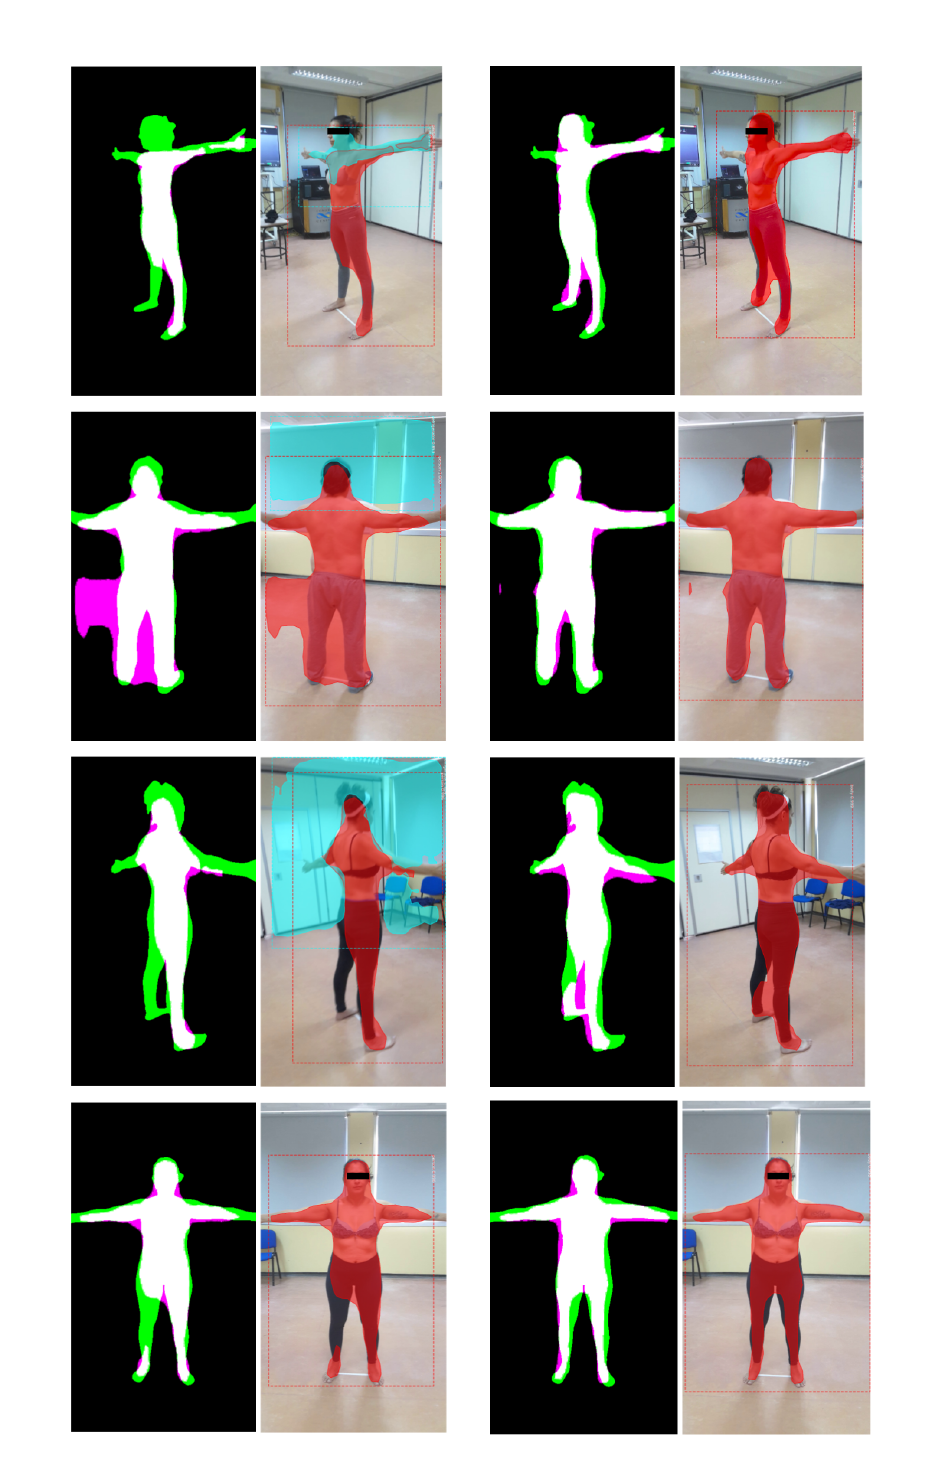
Figure 4. Segmentation examples: Mask R-CNN (left) and BRemNet (right). The segmented mask is superimposed in red to the actual frames. In Mask R-CNN, masks of other identified objects are superimposed in cyan. In masks, true positives are in white, false positives are in magenta, and false negatives are in